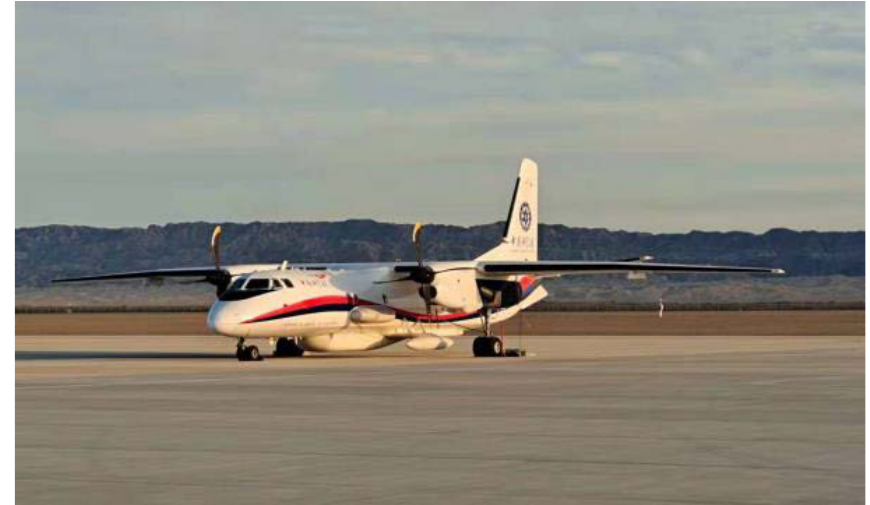
Figure 3. The aircraft platform of the DVD-InSAR